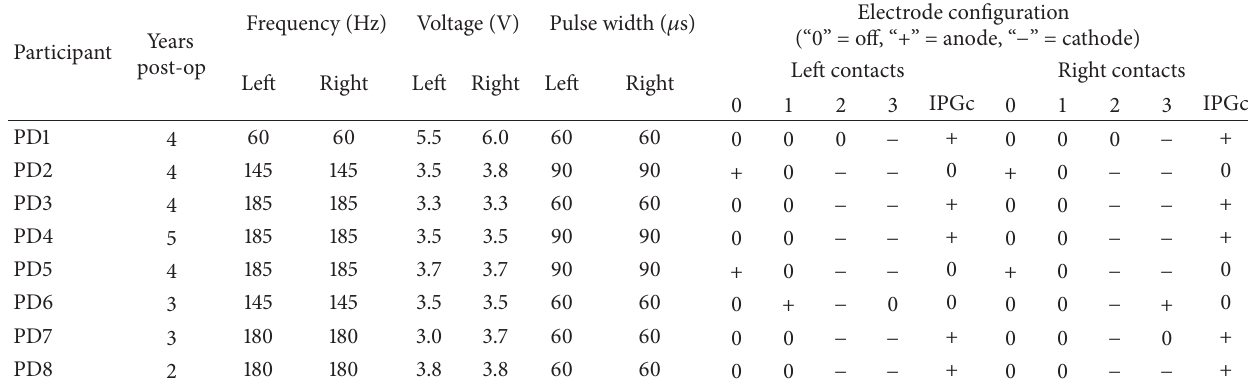
Table 2: Individual DBS